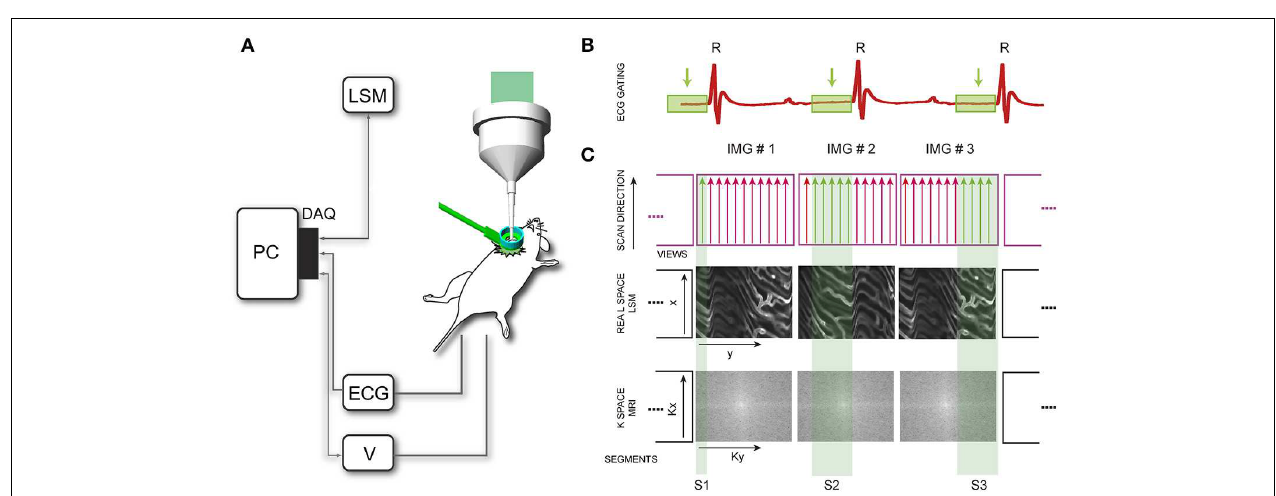
along parallel lines (MRI analog of a segment or group of views). Segments are then sequentially collected within the time-gated window identified in (B) until the entire real space is filled. In a typical high resolution cardiac MRI imaging session instead the sequence of